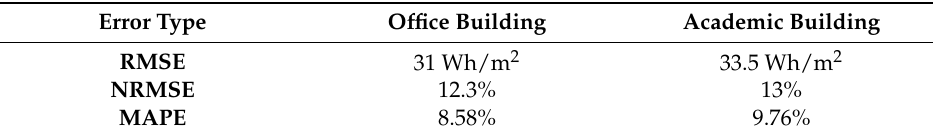
Table 8. Error comparison of MR